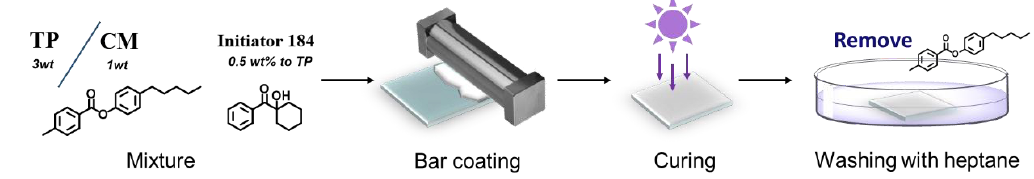
Scheme 2. Schematic of the preparation and UV curing of terpolymer